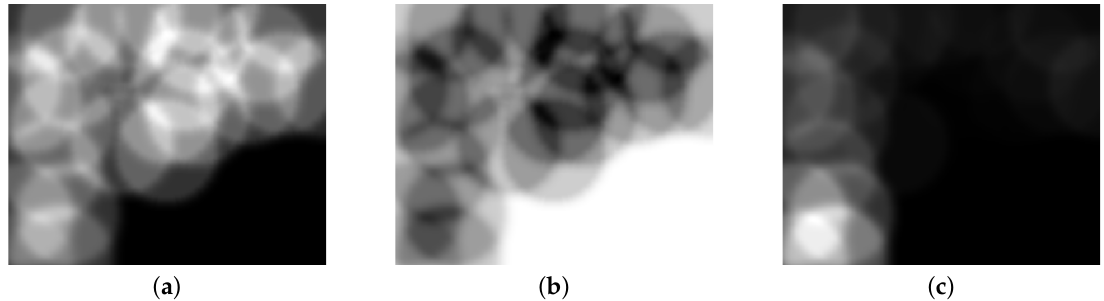
Figure 4. Visibility convolutions derived using sensor uncertainty kernels: ( a ) The probabilistic number of visible landmarks. ( b ) The probabilistic number of invisible landmarks. ( c ) The results of the convolution between the trace-multiplied Gaussian distribution map and the sensor uncertainty kernel.